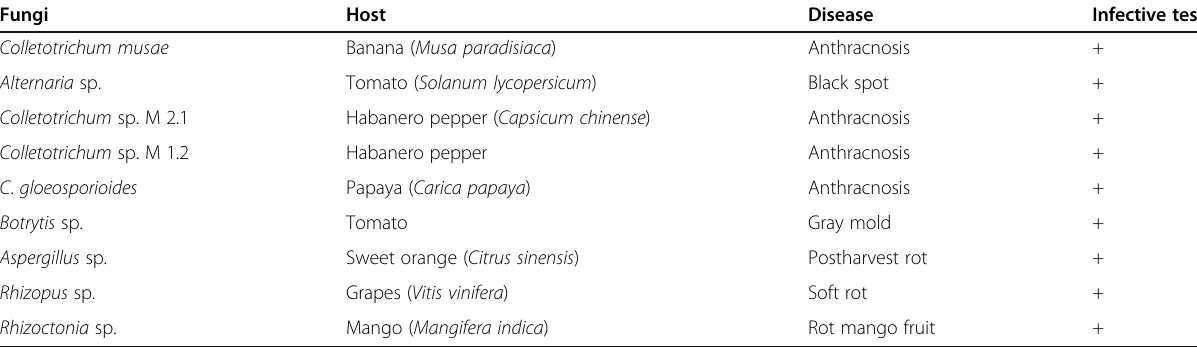
Table 1 List of postharvest fungal pathogens used in the study Fungi